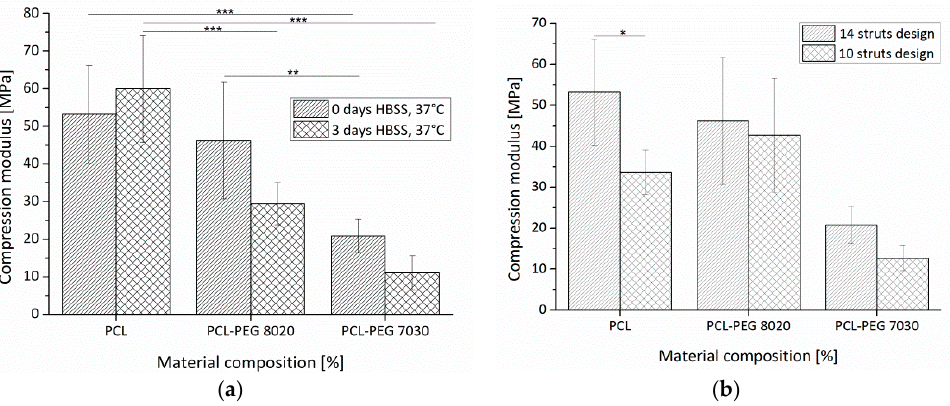
Figure 10. Compressive stiffness of PCL and PCL-PEG blend scaffolds with different compositions in dependence of: ( a ) storage time in HBSS at 37 °C; and ( b ) different scaffolds design. Asterisks denote significant difference of pairwise comparison. * p < 0.05; ** p < 0.01; *** p < 0.001.